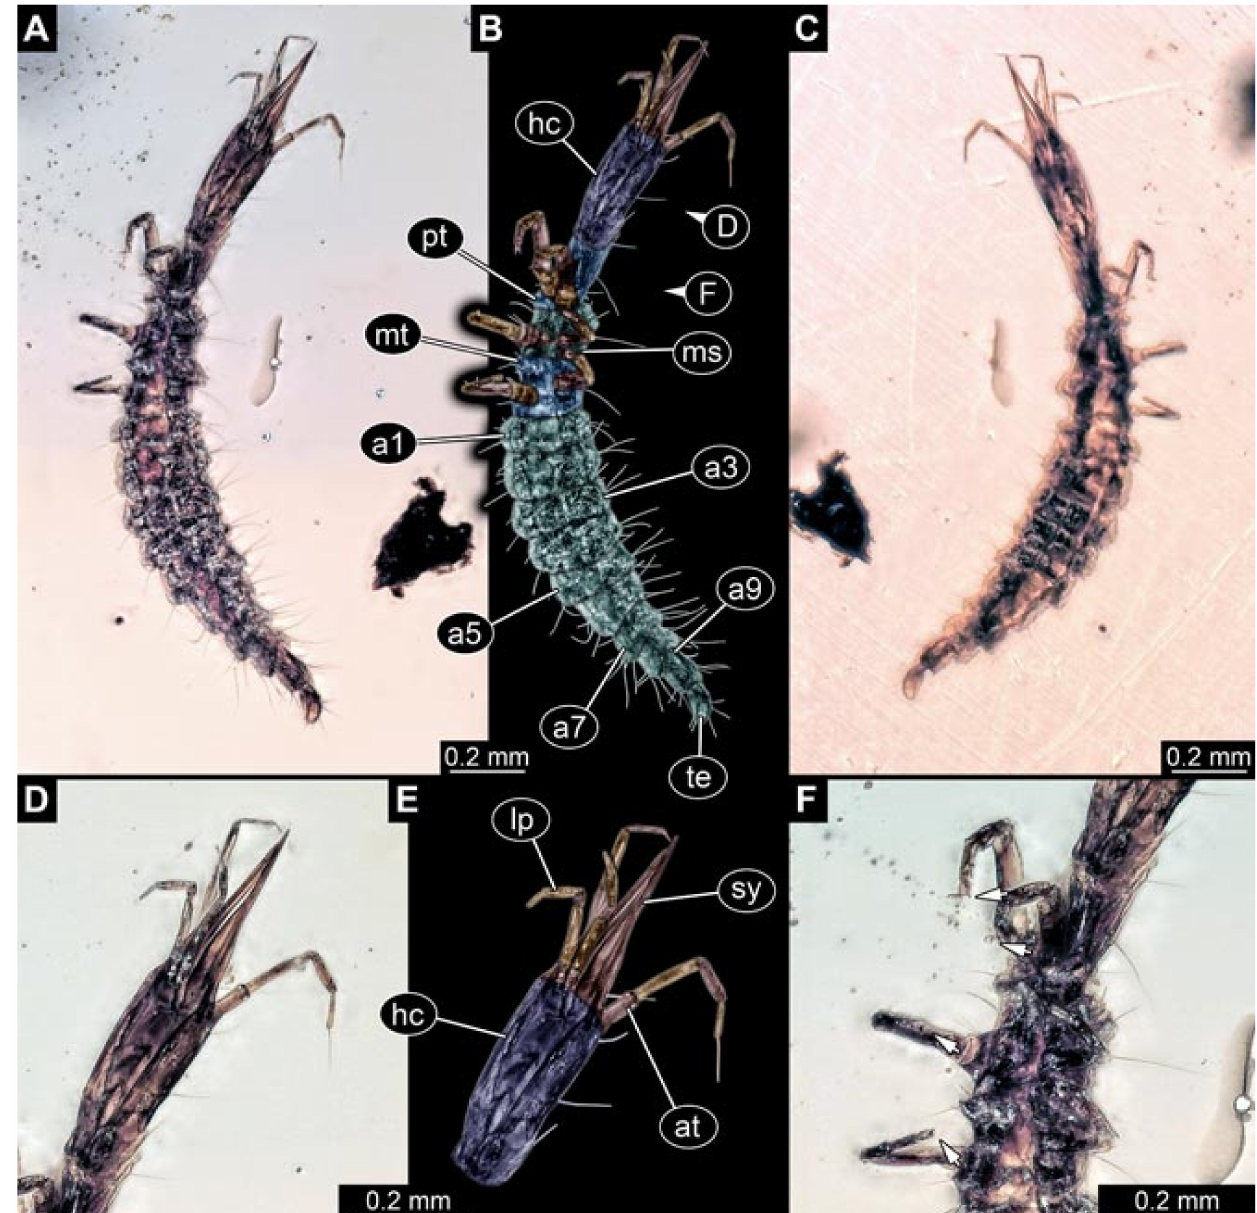
Figure 15. Specimen 5839 (PED 0828); Myanmar amber. ( A ) Ventral view. ( B ) Ventral view, colour-marked. ( C ) Dorsal view. ( D ) Close-up of head in ventral view. ( E ) Close-up of head in ventral view, colour-marked. ( F ) Close-up of trunk appendages with empodia (arrows) in ventral view. Abbreviations: a1–a9 = abdomen segments 1–9; at = antenna; hc = head capsule; lp = labial palp; ms = mesothorax; mt = metathorax; pt = prothorax; sy = stylet; te = trunk